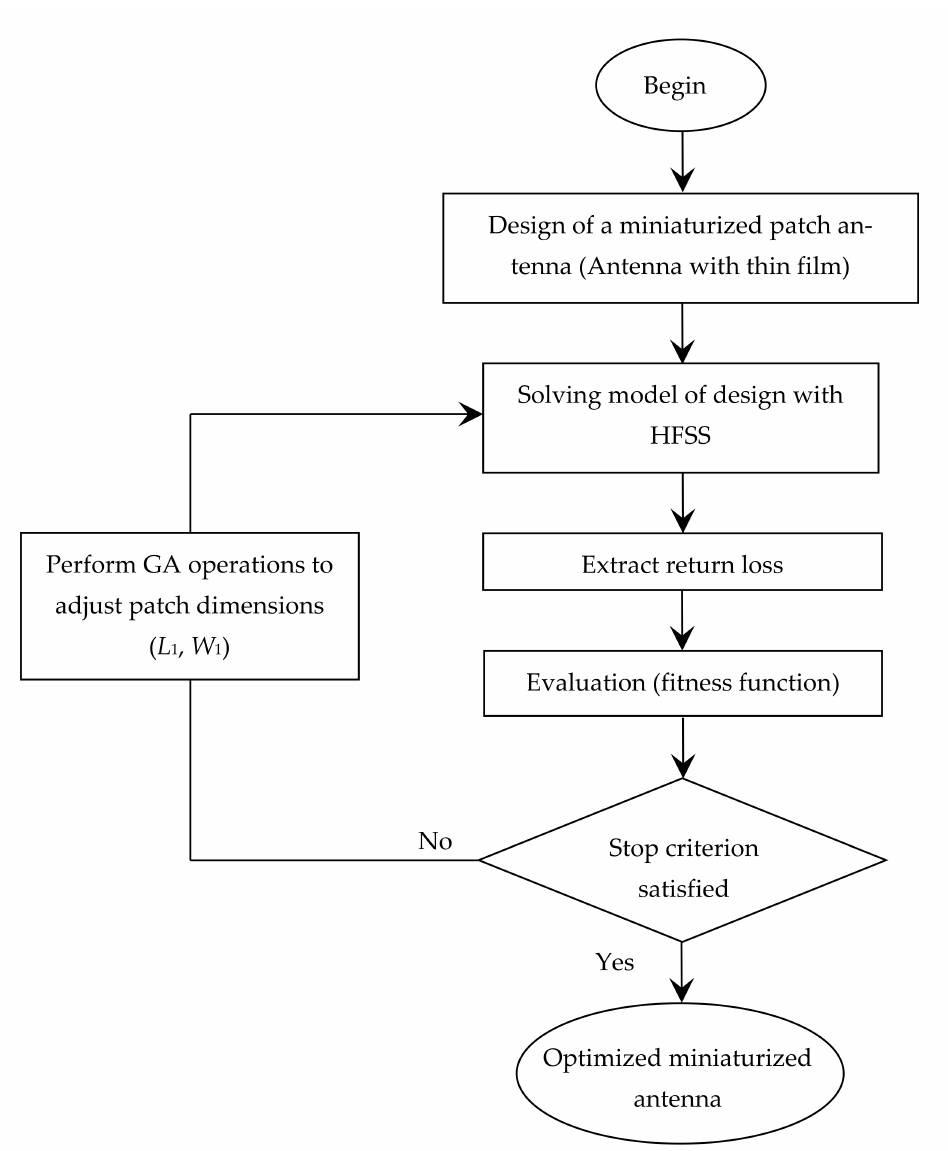
Figure 5. The GA-based optimization process of the microstrip patch antenna with a thin